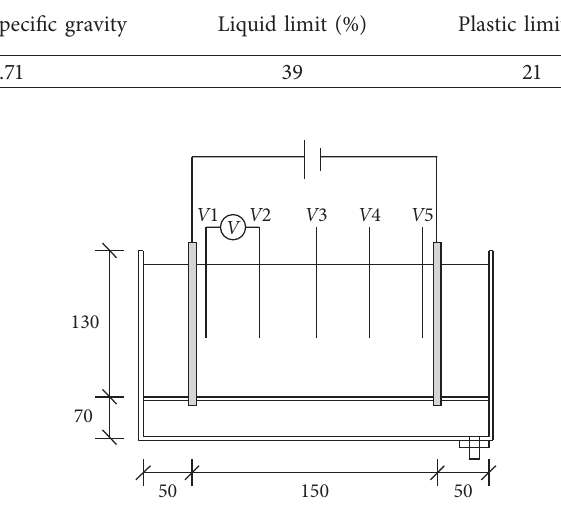
Figure 1: Elevation view of the model.